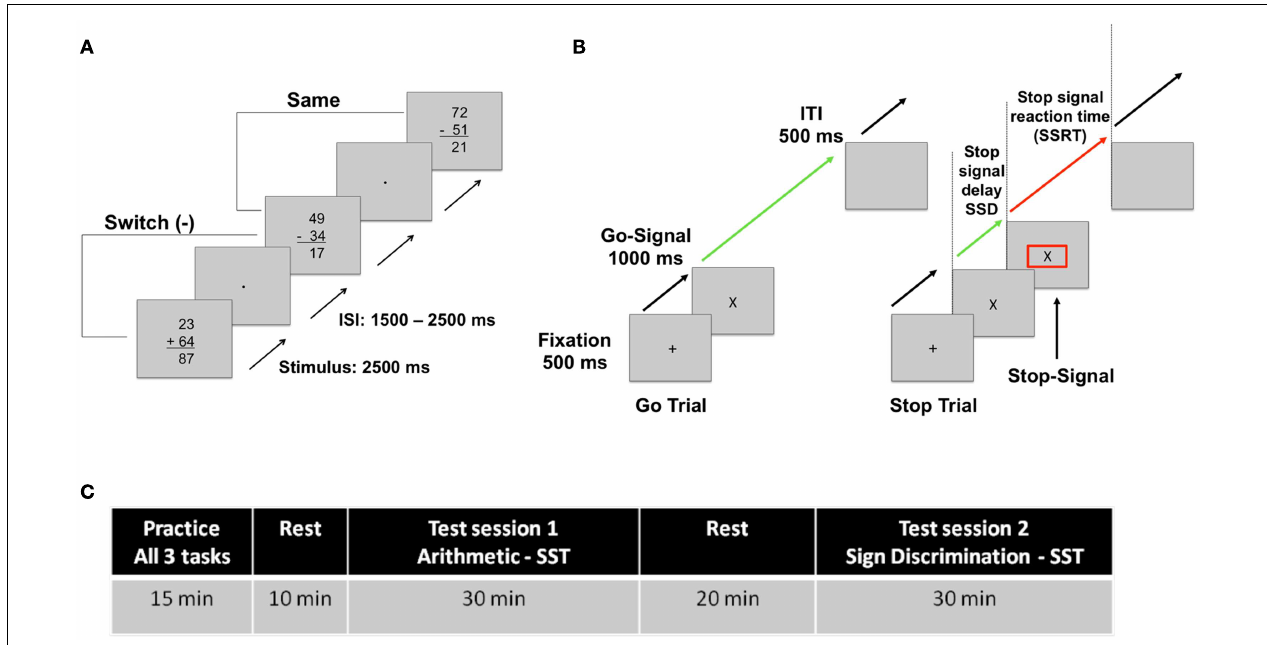
FIGURE 1 | (A) A single trial of the arithmetic and simple sign discrimination task. (B) A go-trial and a strop-trial of the stop-signal task. (C) Experimental protocol timeline.